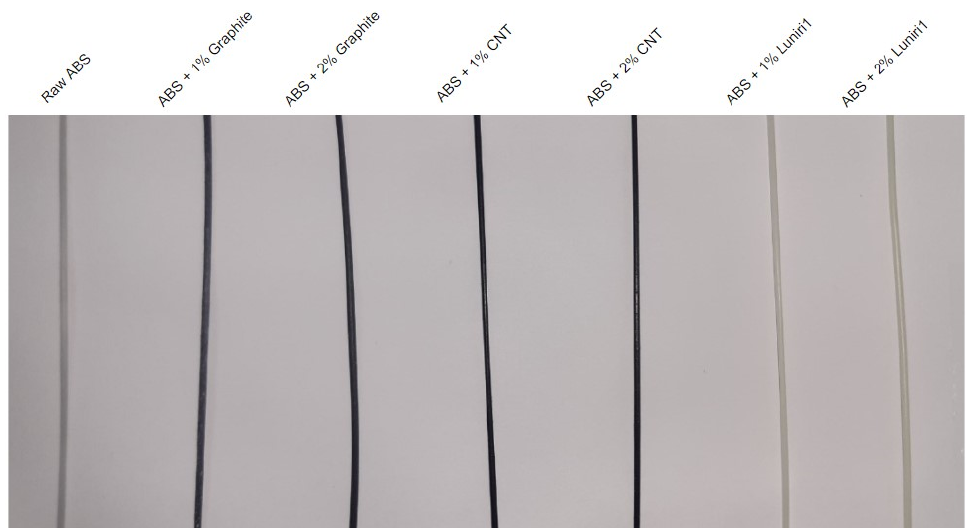
Figure 4. Filament development of ABS with additives.